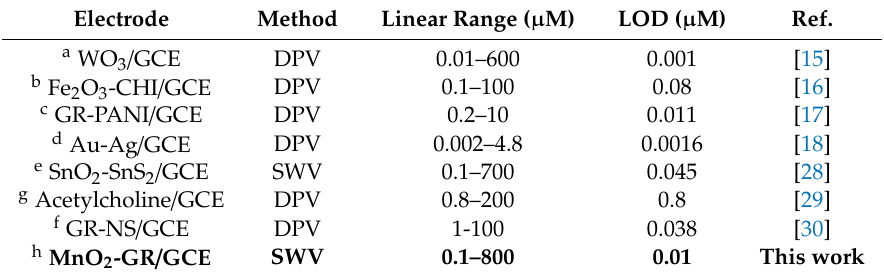
Figure 6. SWVs obtained for various concentrations of SE at MnO 2 -GR/GCE in 0.1 M PBS; inset shows corresponding calibration curve of SE (0.1–150 and 150–800 µM). Table 1. Comparison of previous electrodes for the determination of SE with MnO 2 -GR/GCE.